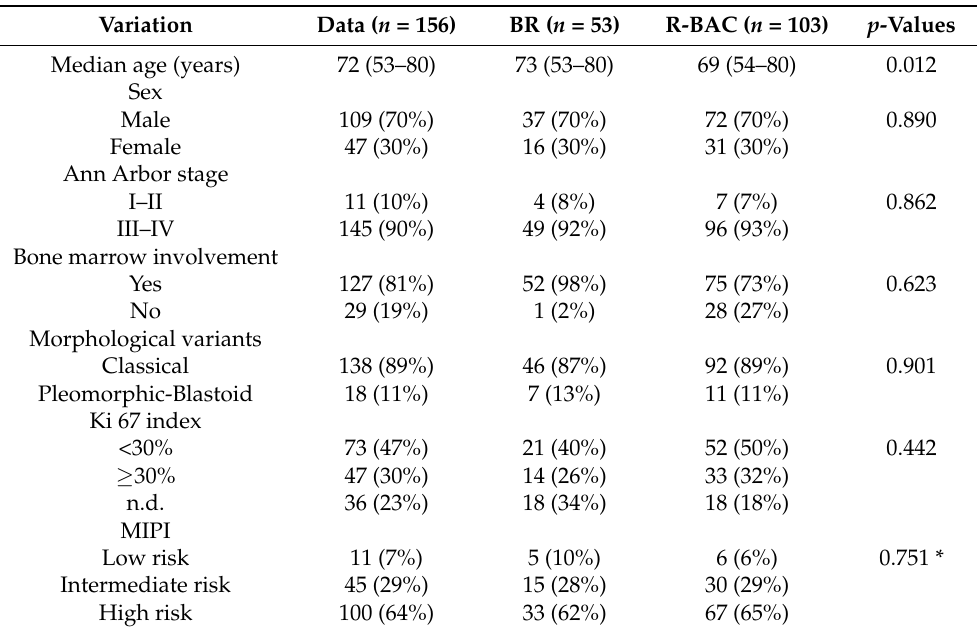
Table 1. Baseline characteristics.